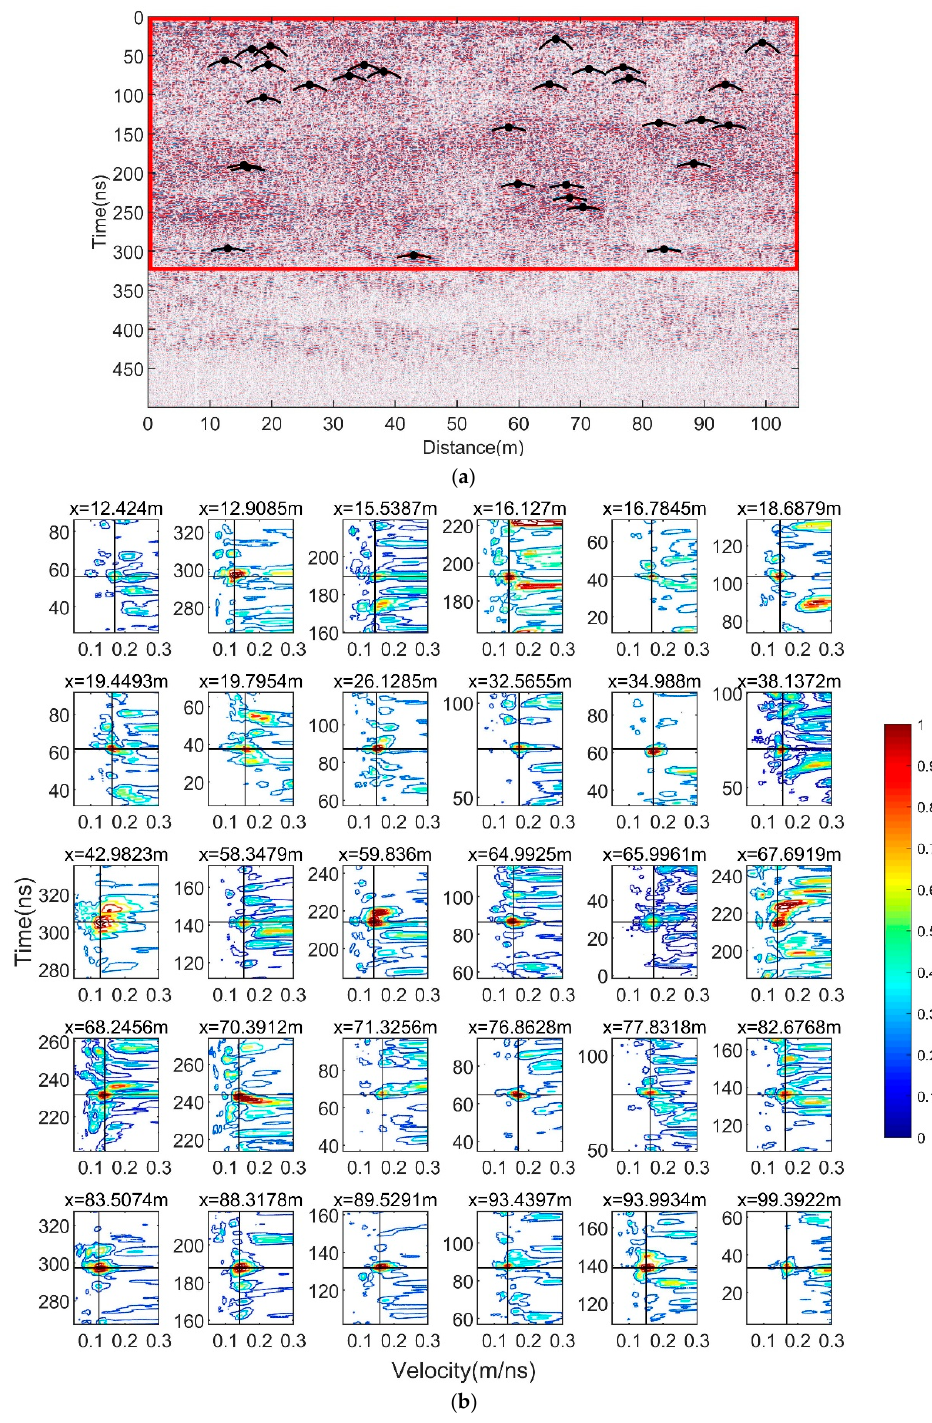
Figure 8. Result of hyperbola selection. ( a ) Hyperbolas on radargram; ( b ) velocity spectrum slices of 30 hyperbolas—the black crossed lines indicate the positions of maximum values.